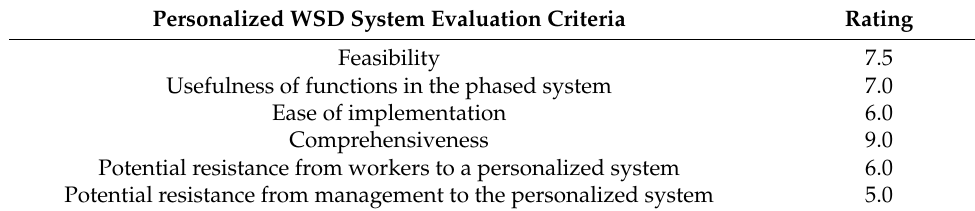
Table 7. Personalized WSD system